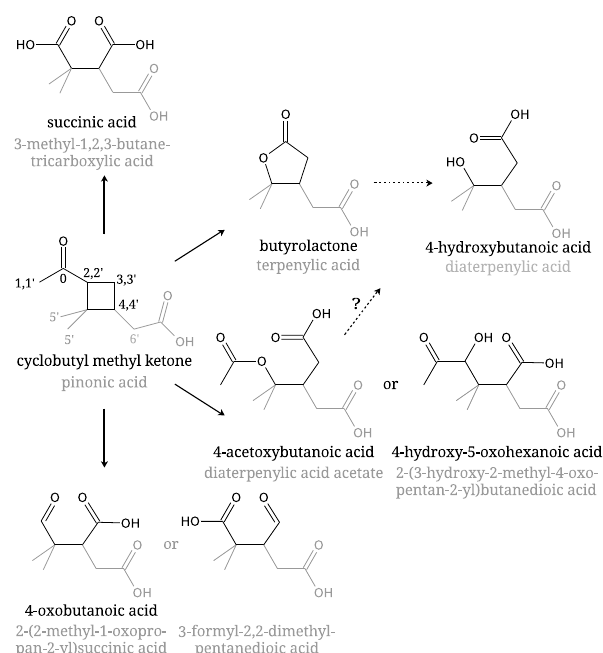
Fig. 1. Chemical structures of cyclobutyl methyl ketone (CMK) and measured or expected products. The added grey moieties represent the analogous products in the pinonic acid system. Butyrolactone (and terpenylic acid) are expected to hydrolyse during sampling, so that 4-hydroxybutanoic acid (or diaterpenylic acid) are detected. No equivalent product of 4-oxobutanoic acid was identified yet, so that two possible structures are proposed for the pinonic acid system: 2-(2-methyl-1-oxopropan-2-yl)succinic acid and 3-formyl- 2,2-dimethylpentanedioic acid. The numbers on CMK/pinonic acid correspond to carbon atoms bound to hydrogen atom(s) available (cid:5) for abstraction by an hydroxyl radical (OH